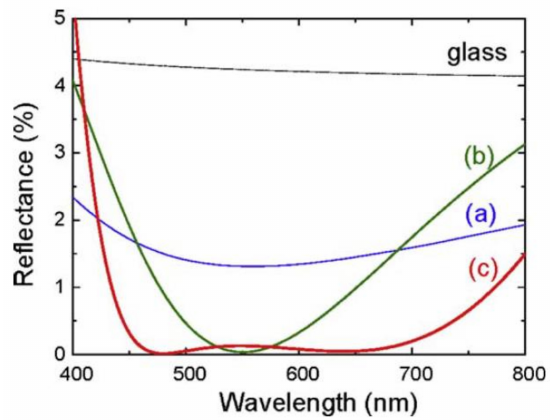
Figure 4. Comparison of reflectance of ( a ) SLARC ( b ) DLARC ( c ) Three-layer ARC. Reprinted with permission [42]; 2010,